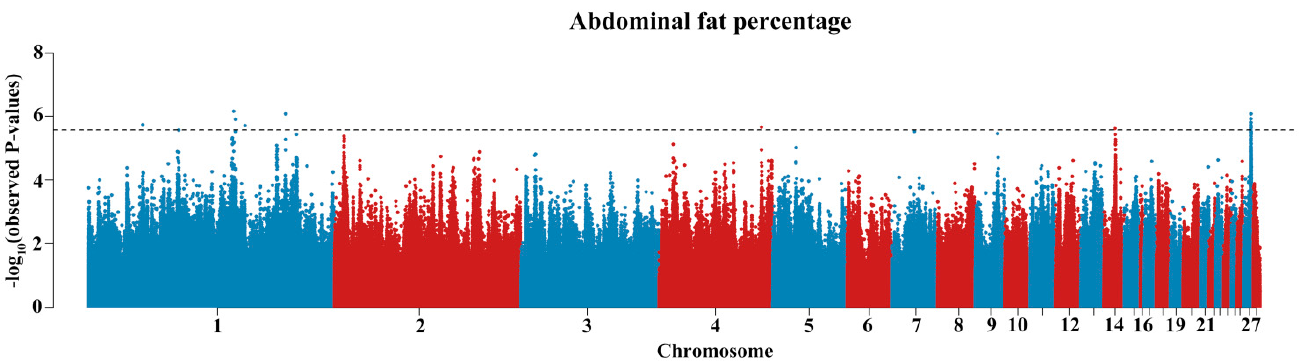
the GWAS threshold explain 3.34 − 5.58% of the observed phenotypic variance. 1 SE values are reported in parentheses. 2 U = upstream, D = downstream.